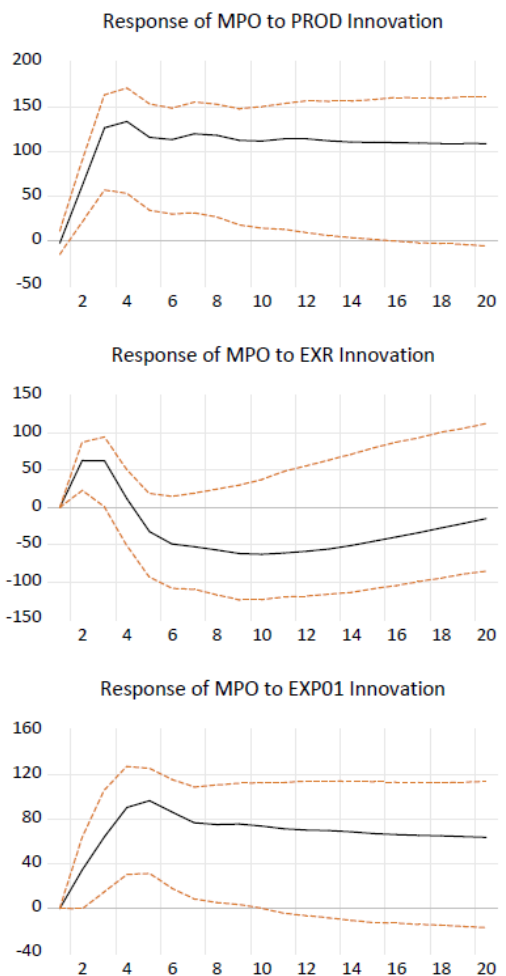
Figure 4. The impulse response of the series of interest, MPO to innovations/shocks in other endogenous variables.